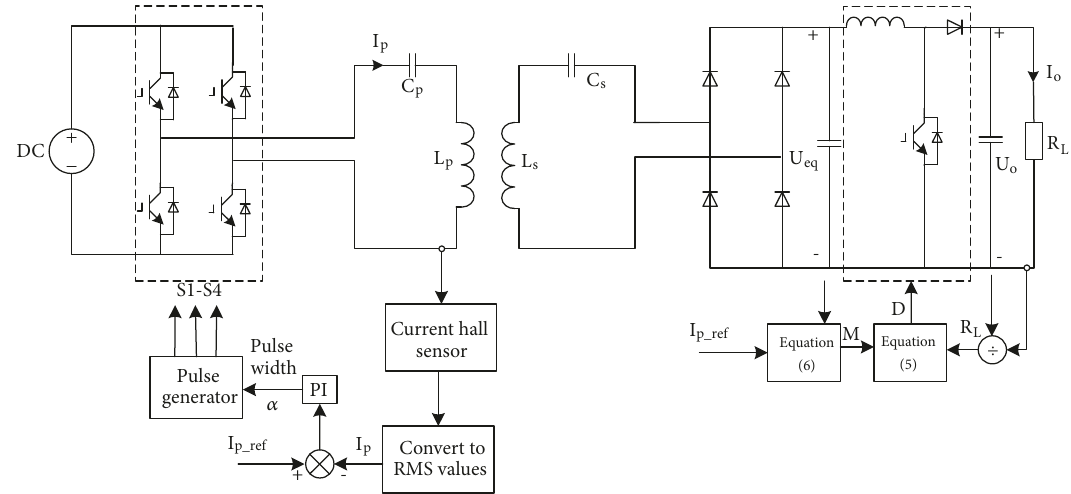
Figure 7: Decoupling control block